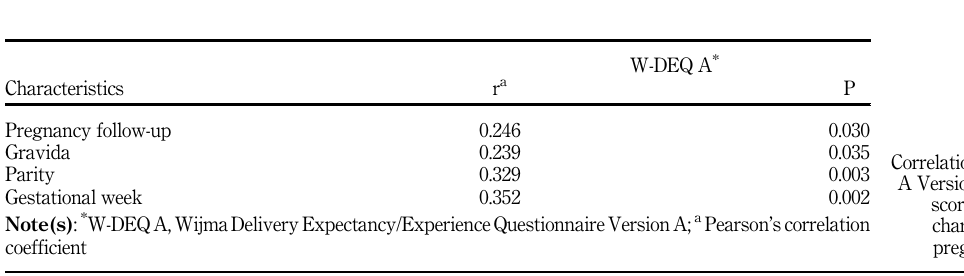
Table 5. W-DEQAVersiontotal